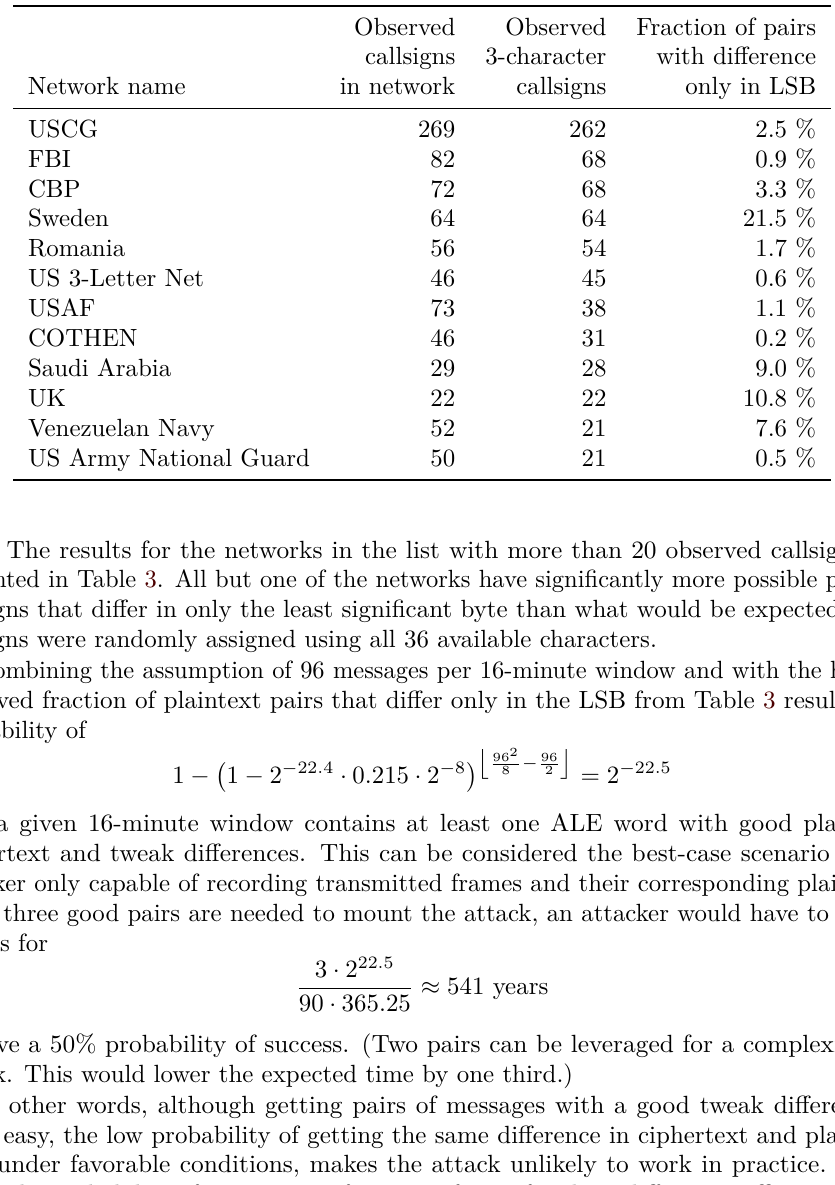
Table 3: Possible call sign pairs in networks with more than 20 observed three-letter callsigns. The data is adapted from the list provided in [ALE21]. It is of uncertain origin and the names assigned to the networks may not reflect their actual operators. (LSB = Least Significant